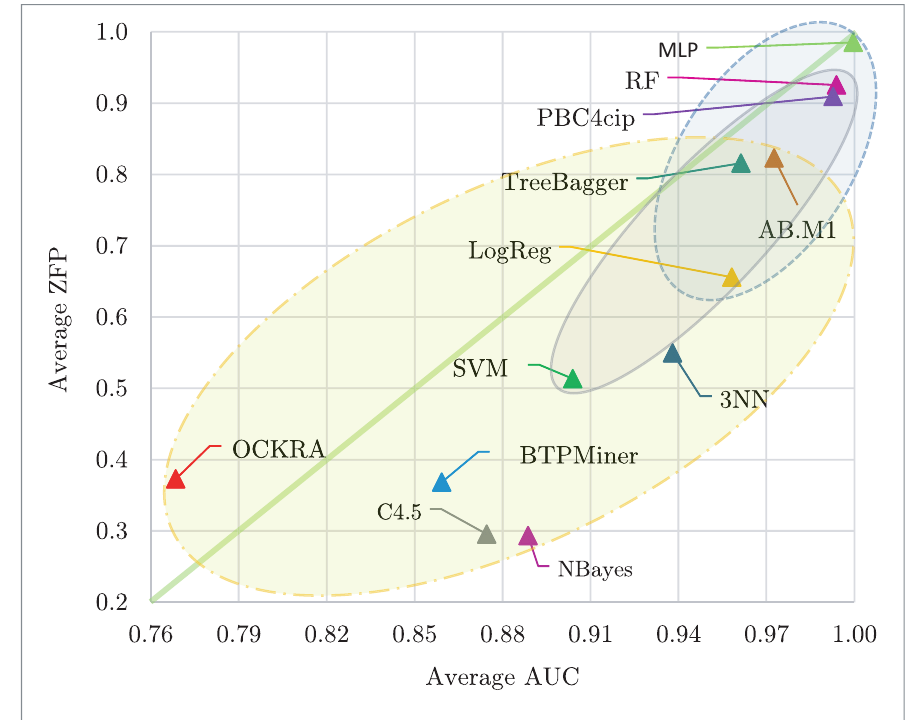
Figure 7. Average AUC vs average ZFP for the tested classifiers. Those results closest to the upper right corner are the best considering both performance metrics; in addition, those enclosed in an ellipse have no statistical differences among them regarding both evaluated